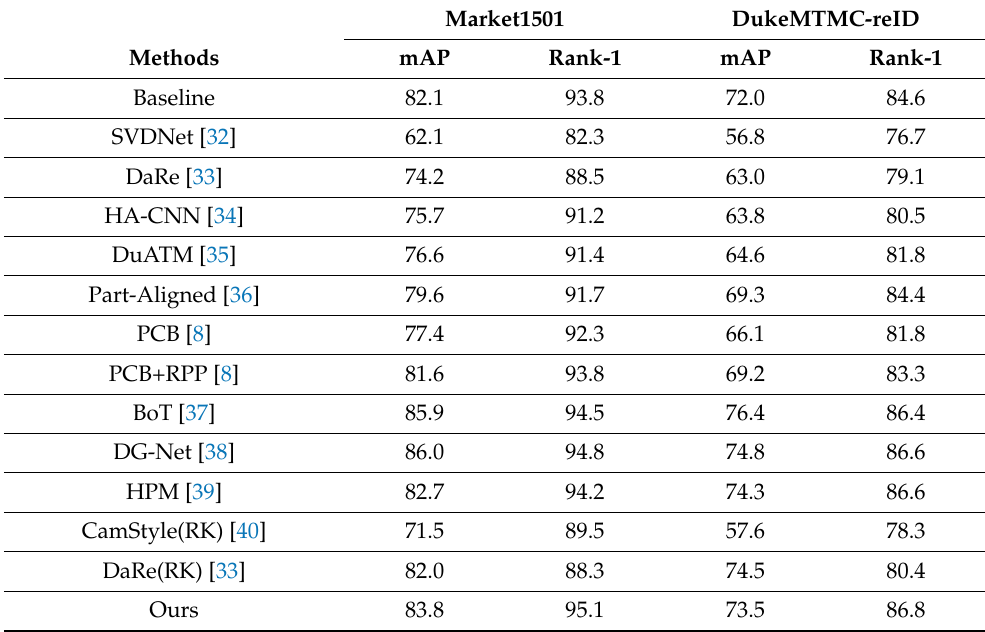
Table 3. Performance (%) comparisons with the state-of-the-art on Market1501 and